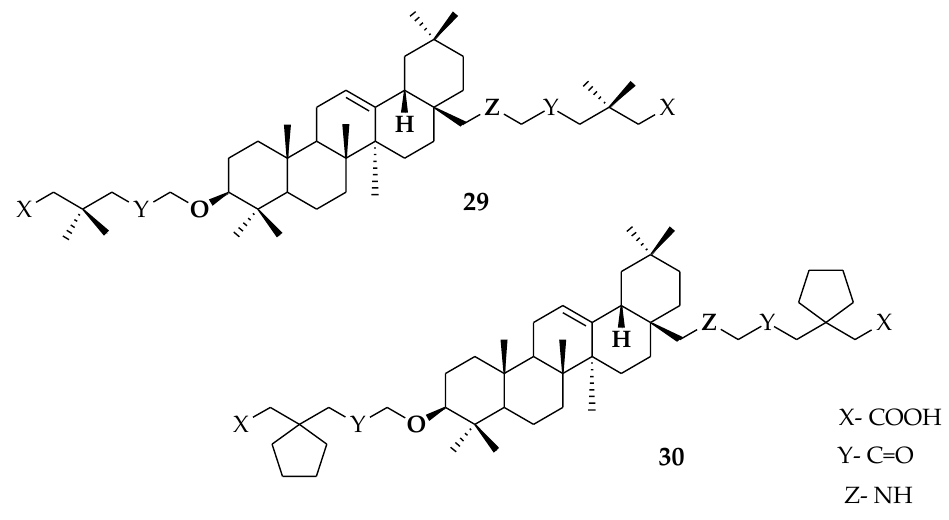
Figure 8. Previously derived OA analogues.